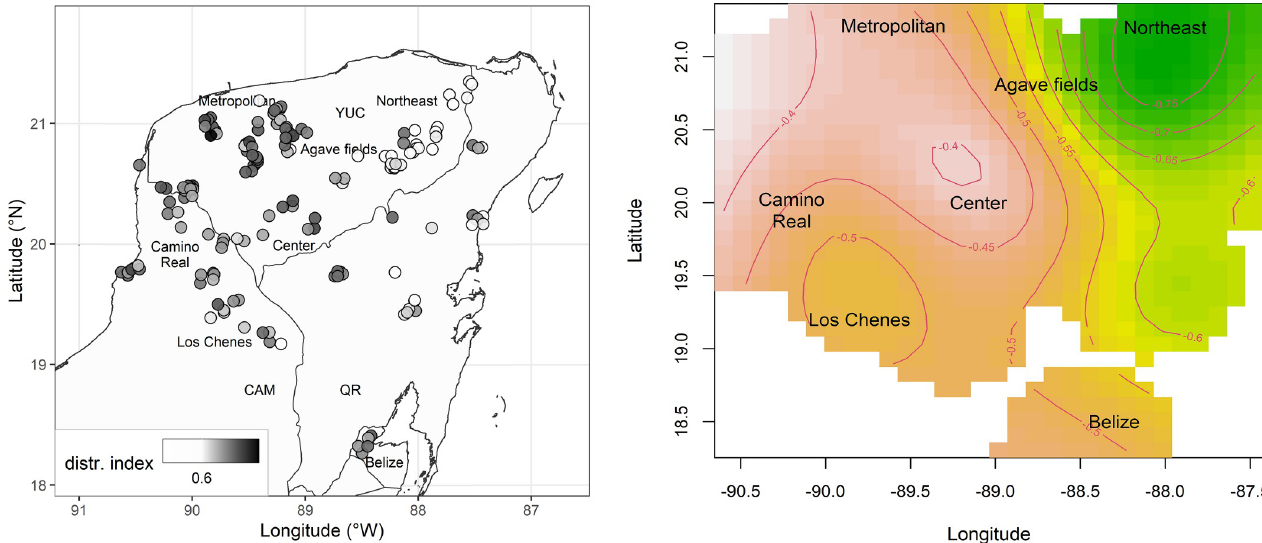
Fig 9. Diffusion of indigenous variants in the population. (A) Average distribution index per speaker. (B) Contour plot of S PACE coefficients (estimates of the smooth term in GAM).